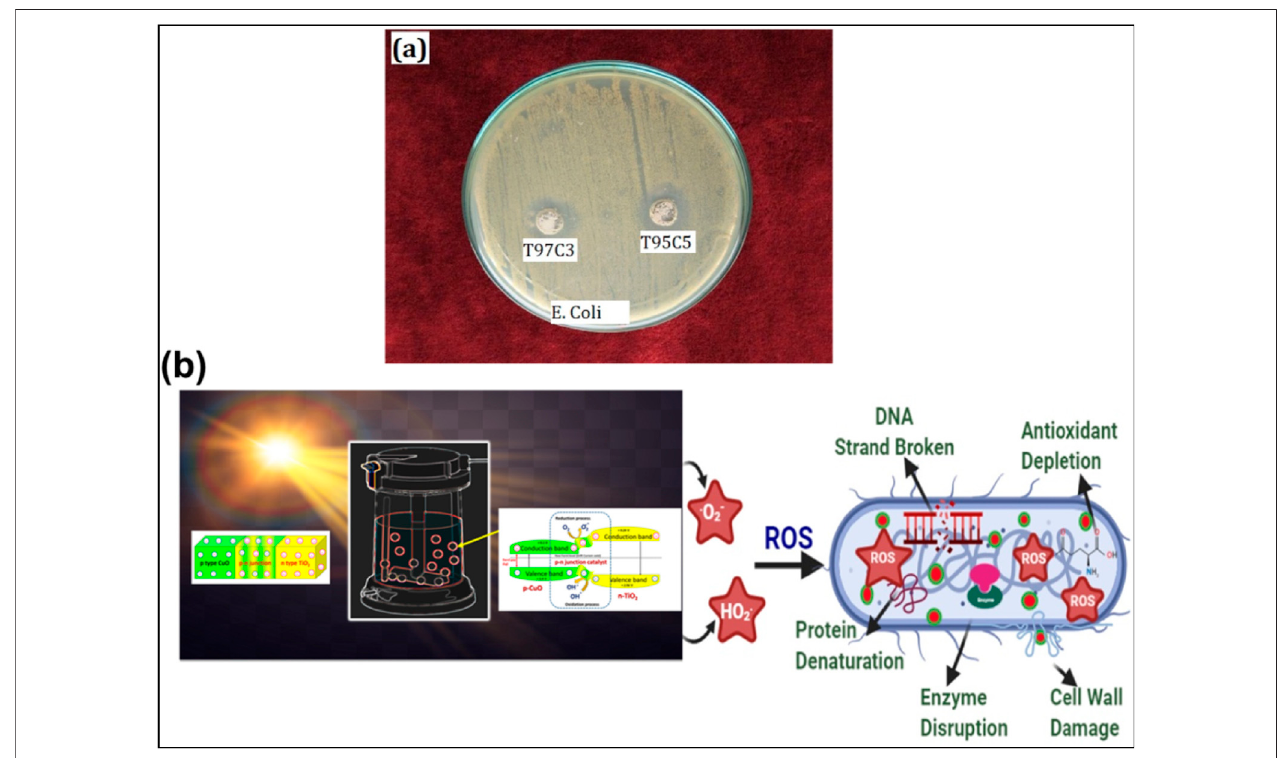
FIGURE 9 | (A) Antibacterial activity and (B) antibacterial mechanism of the p-n junction TiO Gnanasekaran et al. (2021). Copyright © 2021 Elsevier Ltd.